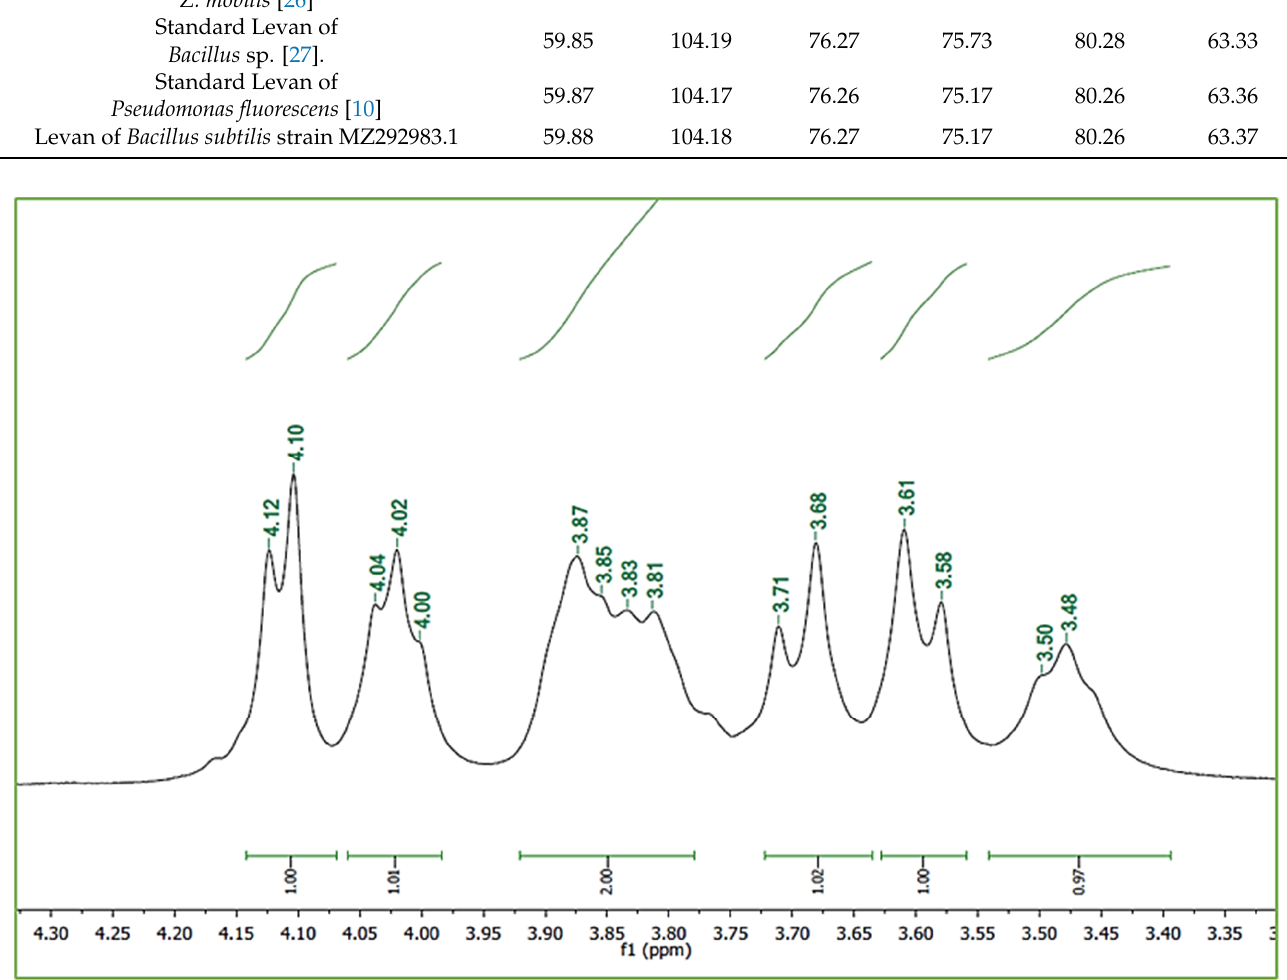
Figure 3. 1 H NMR spectrum of levan from Bacillus subtilis strain MZ292983.1. The recorded spectrum was recorded at 400 MHz for the sample in D 2 O.